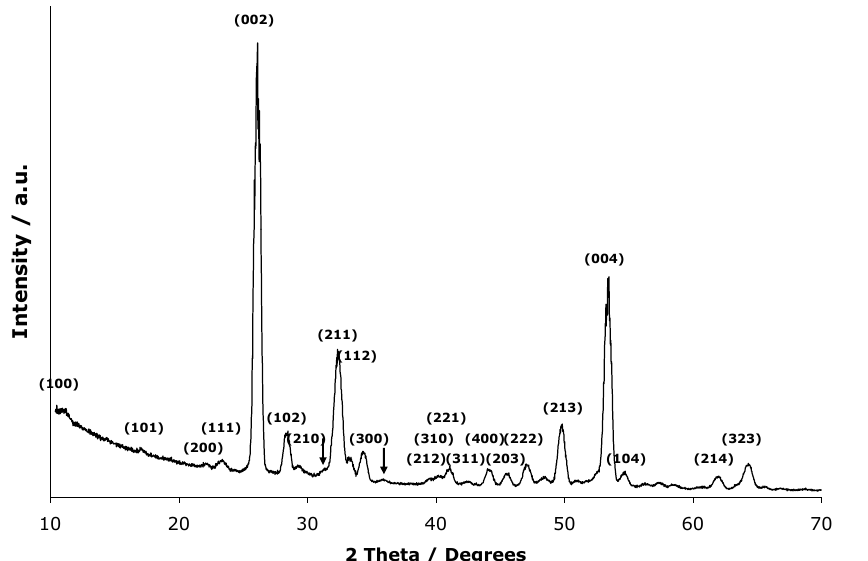
Figure A2. XRD plot for a Plasma Biotal plasma sprayed copper backed target. All major di ff raction planes are indexed. Arrows indicate potential β -TCP secondary phase, however, with the low intensity accurate quantification is di ffi